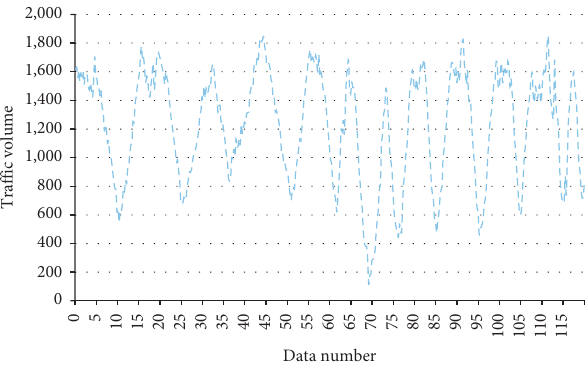
Figure 8: Predicted results of BiLSTM.